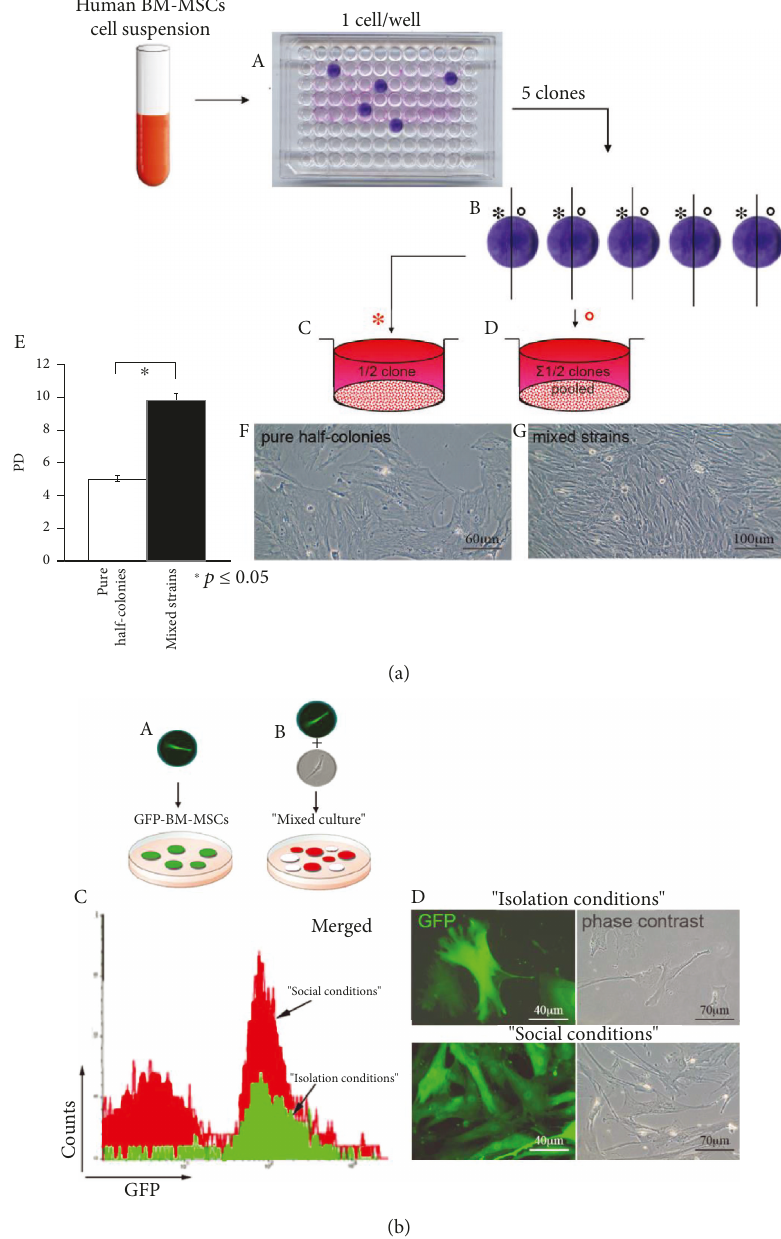
Figure 5: Clonal expansion is a biological property of MSC acquired in a social context. (a) Five individual colonies ( 6 × 10 3 cells/colony) formed at cloning dilution in 96-well plates in FBS-supplemented culture medium (A) were trypsinized and split in half (B), and each half was replated either alone (C) or pooled with all other half clones (D). Individual pools were subdivided into 5 samples, each containing the same number of cells and replated in 6-well plates. Pure half colonies underwent senescence after 5 PD, whereas expansion of mixed strains, including the same number of cells as pure half colonies, continued for > 10 PD (E). Culture images (F, G) shown are representative results. These experiments showed that promiscuous strains resumed the ability for e ffi cient expansion, whereas pure clonal strains remained growth impaired ( n = 5 ). (b) Assay for secondary CFE and growth potential of BM-MSC strains. 100 BM-MSCs transduced with GFP-lentiviral vectors were plated at clonal density either alone or together with 100 nontransduced BM-MSCs (A, B). After 14 days in culture, CFE was identical, but a 3-fold higher cell number was determined by FACS analysis (C), and a 2-fold higher PD was observed for GFP-BM-MSCs in the mixed cultures compared to the “ pure ” GFP-BM-MSCs ( n = 5 ). Scale bars represent 40 μ m, 60 μ m, 70 μ m, and 100 μ m as